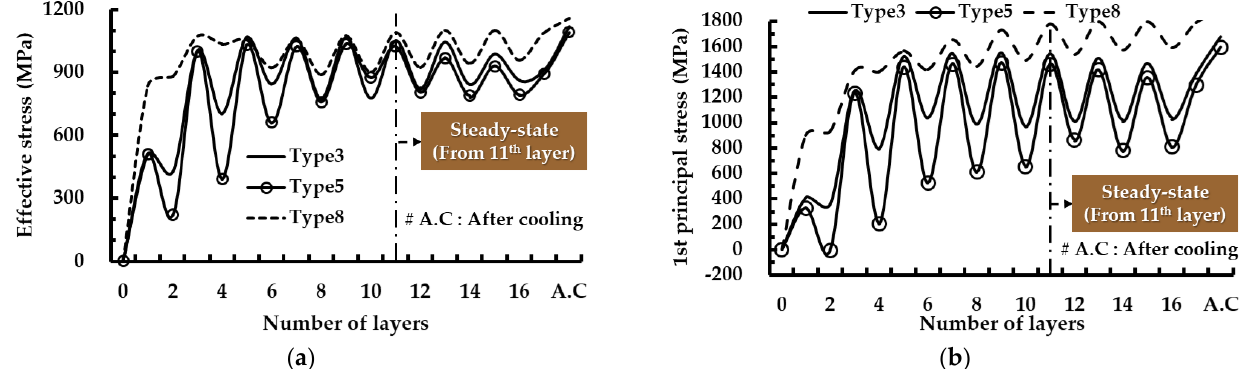
Figure 13. Histories of residual stresses at the location of maximum stress for different FDSs (large volume deposition): ( a ) effective stress; ( b ) first principal stress.